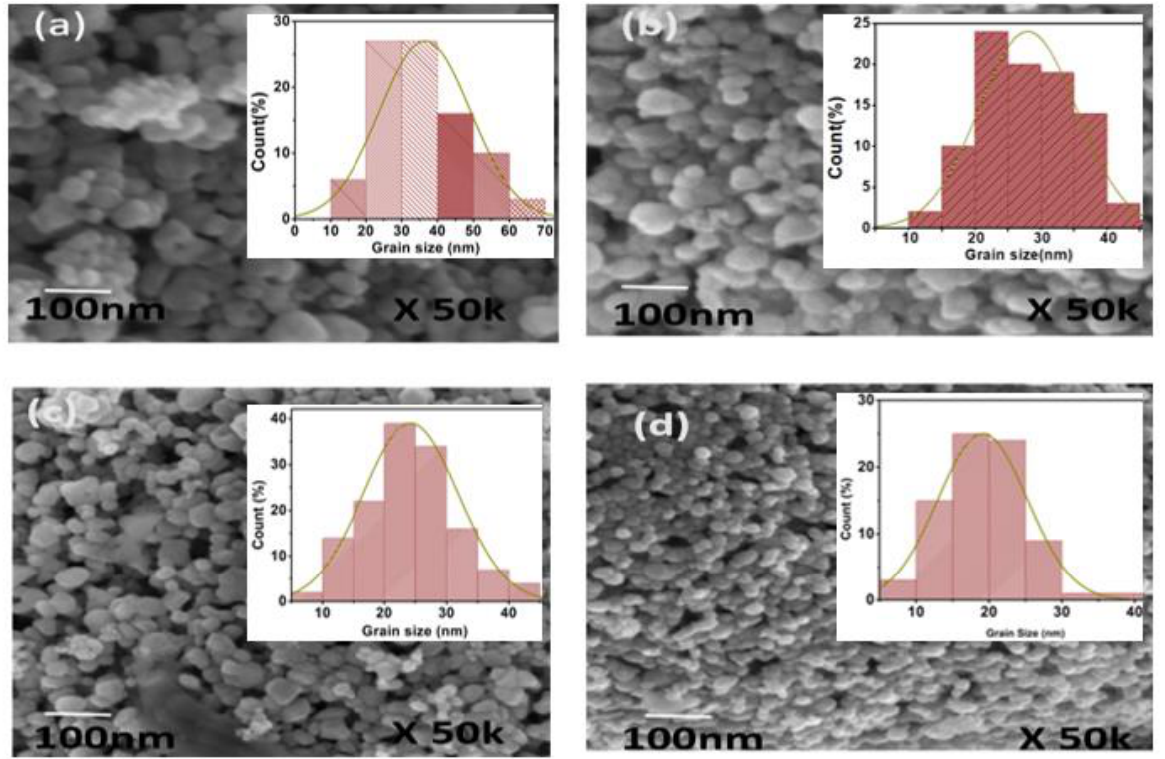
Figure 3. SEM images and size distribution histogram of the green synthesized NiO thin films on Cu substrate prepared at rotational speeds (RS) of ( a ) 700 RPM, ( b ) 900 RPM, ( c ) 1100 RPM, and ( d ) 1300 RPM.